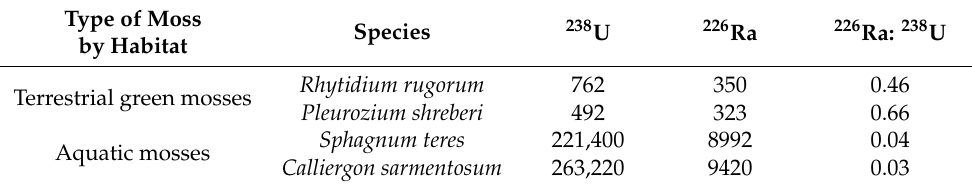
Table 9. Concentrations of 238 U and 226 Ra in the ash of mosses collected in the study area, Bq/kg. Type of